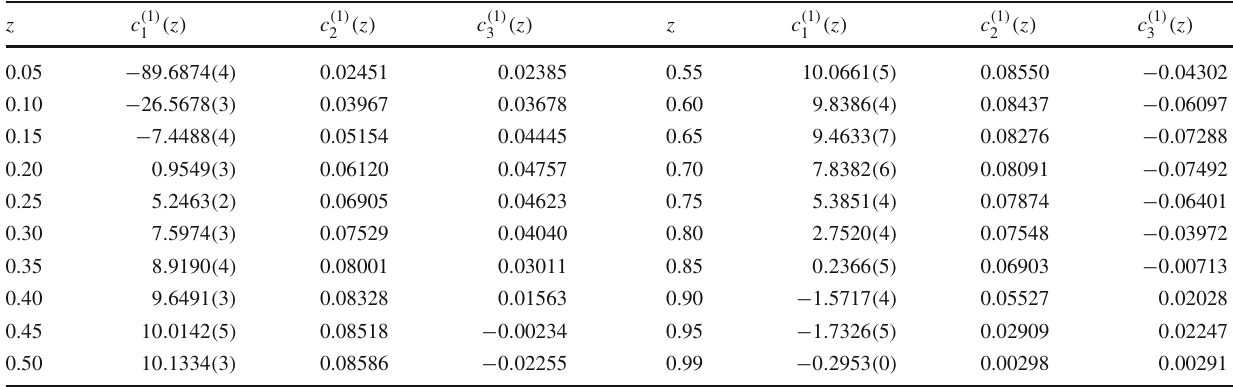
( z ) as introduced in (17). We caution that the actual values 1 , 2 , 3